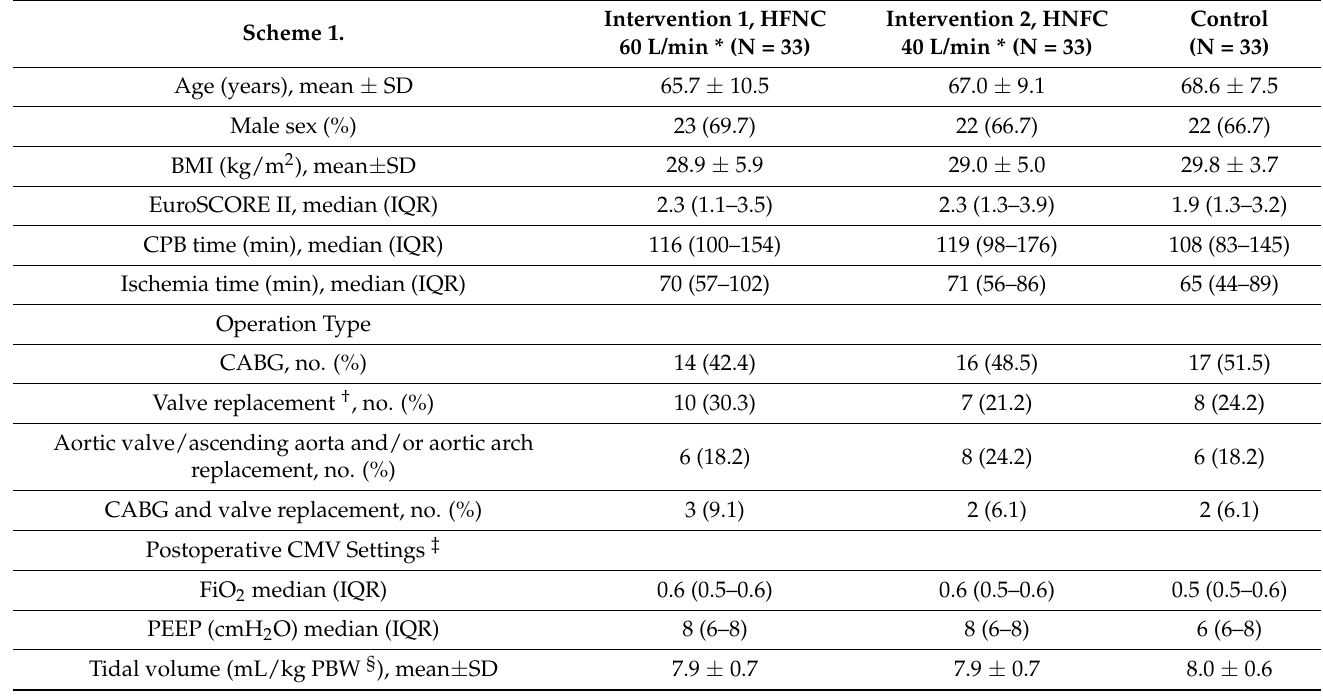
Figure 1. The study flow chart. Treated as randomized is defined as treated according to study protocol, without fulfilling the prespecified criteria for treatment failure as detailed in the Methods. CICU, cardiothoracic intensive care unit; SBT, spontaneous breathing trial; COPD, chronic obstructive pulmonary disease; CPAP, continuous positive airways pressure; PaO 2 /FiO 2 , arterial oxygen partial pressure to inspired oxygen fraction ratio; GCS, Glasgow Coma Score. * The remaining patients in each group (intervention group 1, n = 4; intervention group 2, n = 10; control group, n = 18) received escalation of respiratory support in the context of fulfilling predefined criteria for treatment failure (also see Methods). Table 1. Demographics and baseline clinical characteristics for the three study